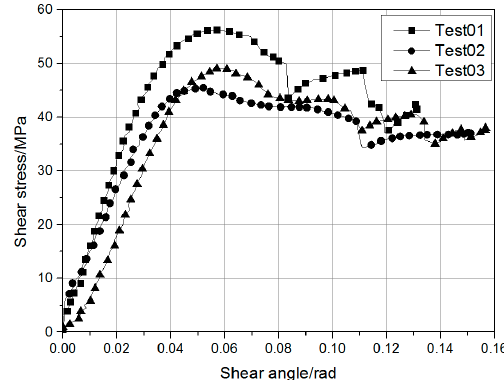
Figure 1. Shear stress vs. shear angle curve.